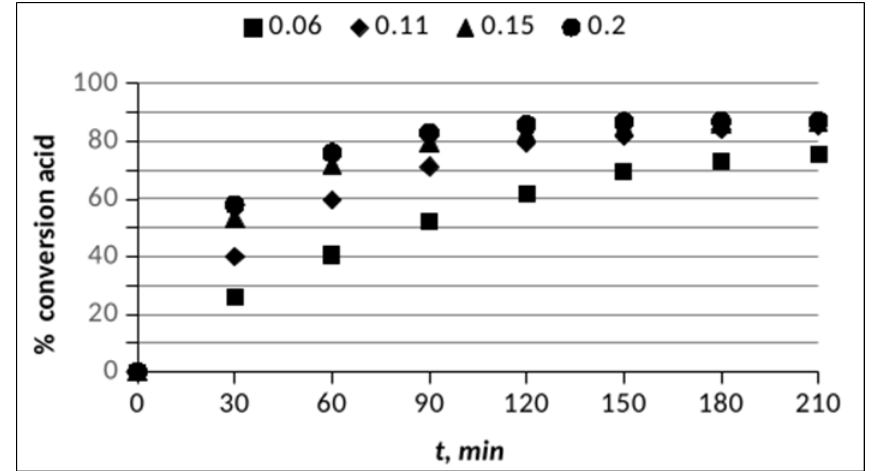
Figure 4. Influence of the catalyst (H SO ) amount on the kinetics of esterification of 2 4 propanoic acid with 1-propanol. Conditions: acid/alcohol molar ratio 1/10; temperature 45°C; acid/catalyst molar ratios: 1/0.06; 1/0.11; 1/0.15 and